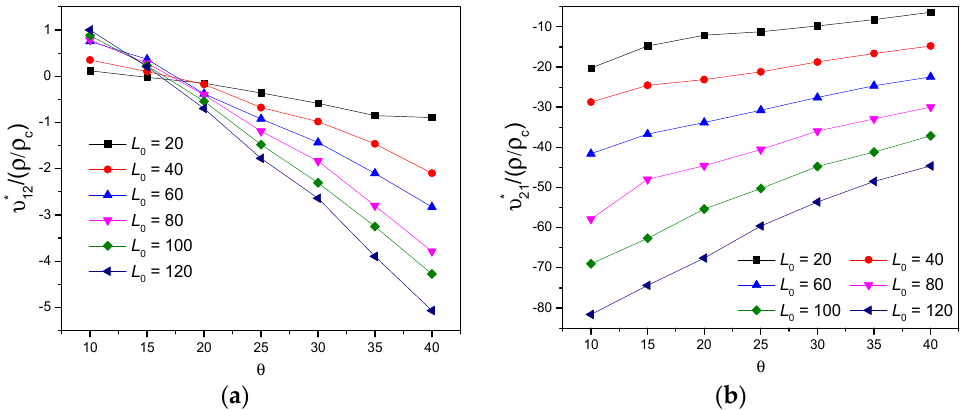
Figure 14. Variations of the ratio between effective Poisson’s ratio and relative density verse θ L 0 and θ , when t = 2: ( a ) υ ∗ / ( ρ / ρ c ) , ( b ) υ ∗ / ( ρ / ρ c ) 12 21 parameters , when L and 0